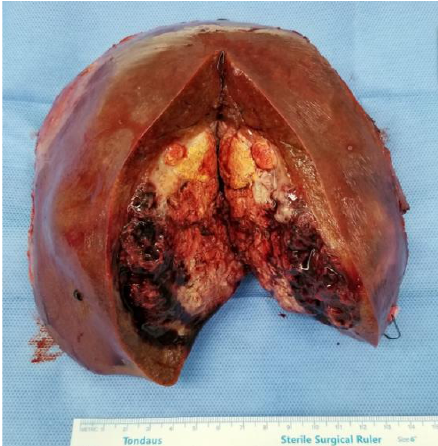
Figure 2. Gross specimen of the right hemihepatectomy. A nine-centimeter-sized tumor with multifocal necrosis and internal hemorrhage.